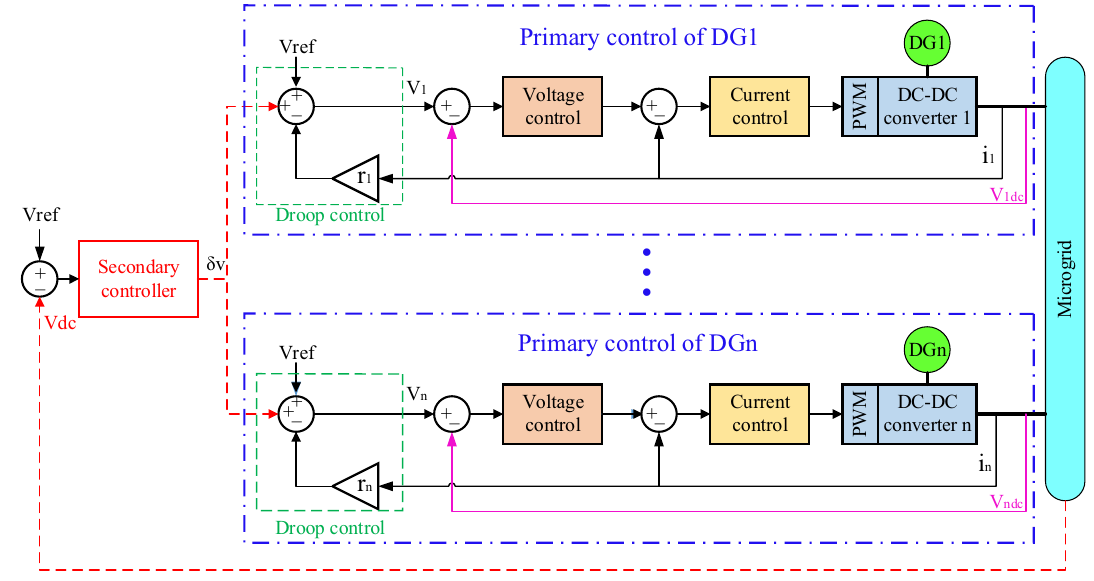
Figure 1. Primary and secondary control in the